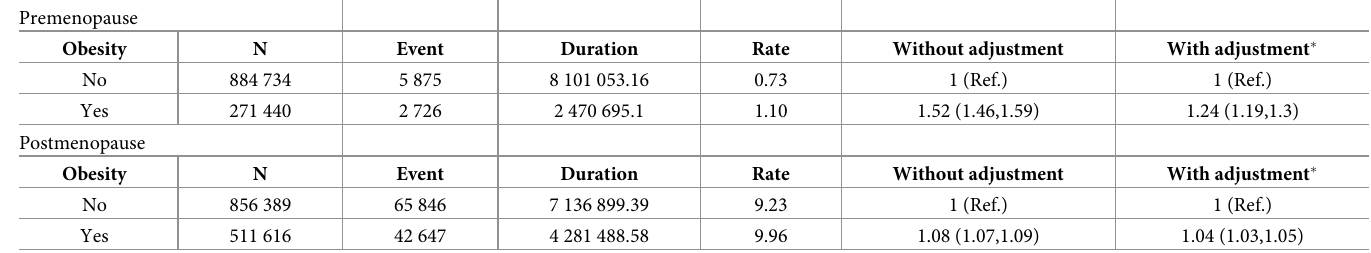
Table 2. Cox proportional hazards regression analysis for the development of vertebral fracture according to obesity status based on body mass index in the pre- menopausal and postmenopausal groups.